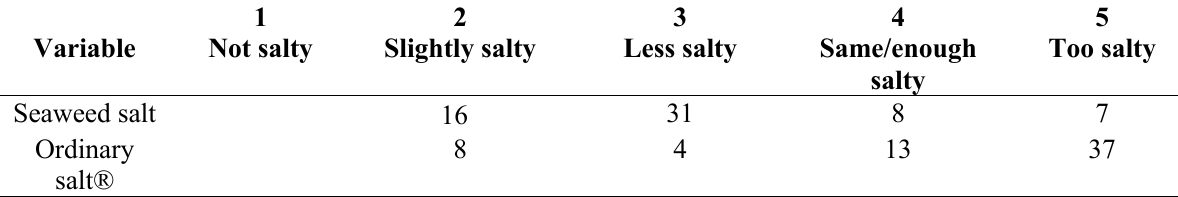
Chi-square test, p =